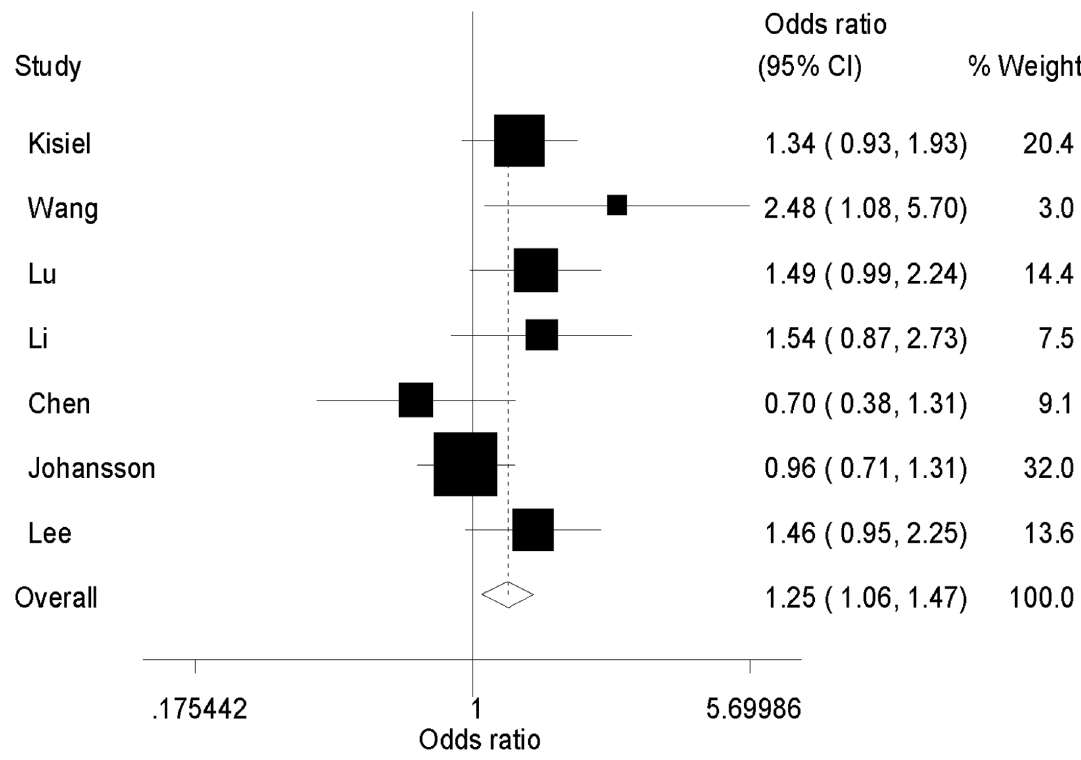
Figure 3. Forest plot of the association between SLE susceptibility and ESR1Pvu II polymorphism (CC/CT versus TT).